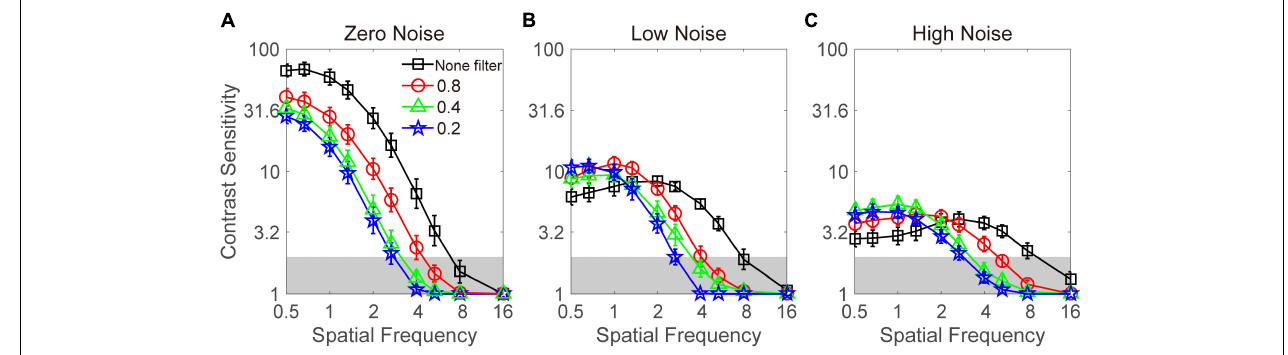
FIGURE 3 | Contrast sensitivity functions under zero- (A) , low- (B) , and high- (C) noise conditions. Dark lines with square symbols, red lines with circle symbols, green lines with triangle symbols, and blue lines with pentagram symbols denote contrast sensitivity with none filter and at the 0.8, 0.4, and 0.2 filter levels, respectively. Data were averaged across subjects. Shaded regions denote contrast sensitivity which is lower than 2. Error bar denotes standard error.